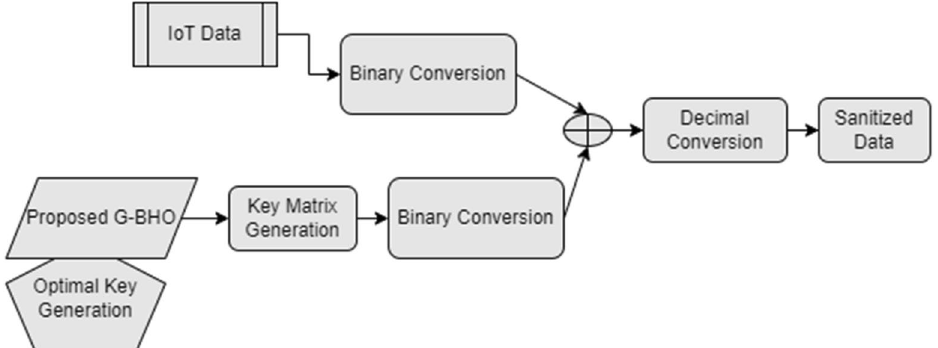
Figure 4. Data sanitization process.